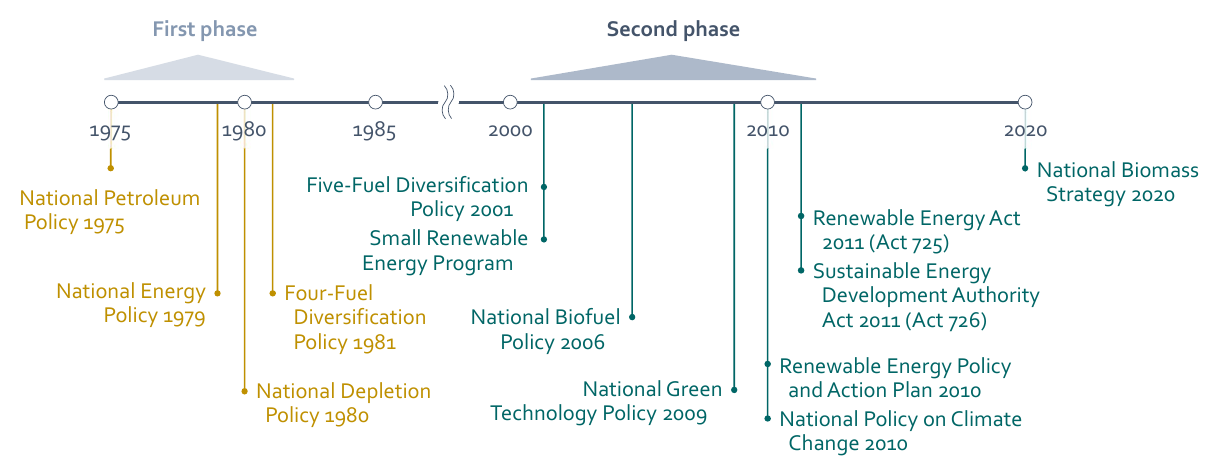
Figure 7. Summary of major energy policies in Malaysia from 1975 to